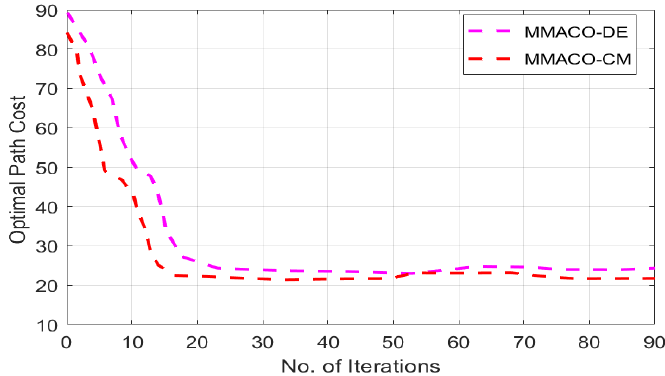
Figure 7. Estimation costs of MMACO-DE and MMACO-CM.